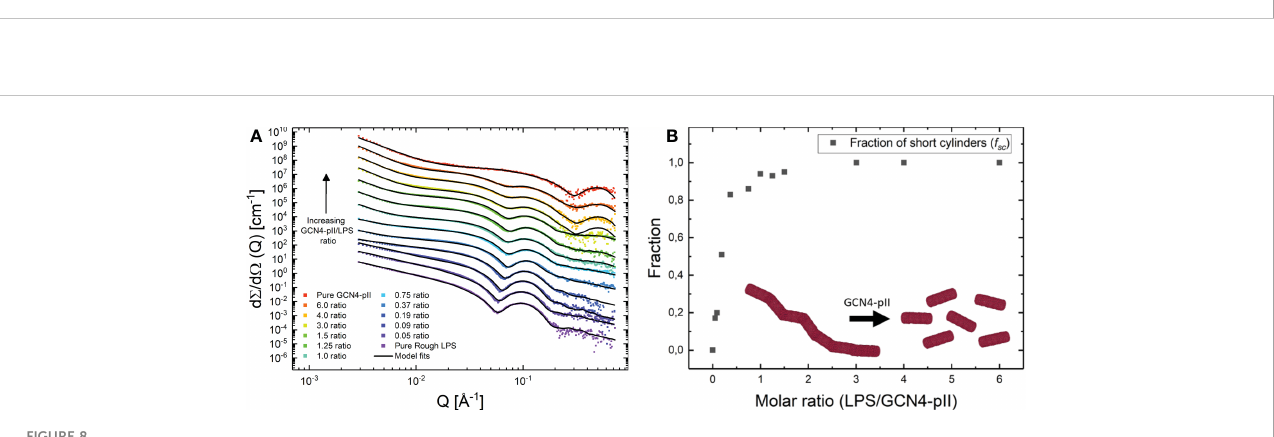
FIGURE 8 (A) SAXS data from samples containing mixes of rough LPS and GCN4-pII in varying molar ratios (GCN4-pII/LPS). For clarity, the data has been shifted vertically with factors 6 n where n goes from 0 to 12 from bottom to top. The solid lines display fi ts of the quantitative scattering models. (B) Fraction of short cylinders as a function of molar ratio (GCN4-pII/LPS) obtained from the fi ts shown to the